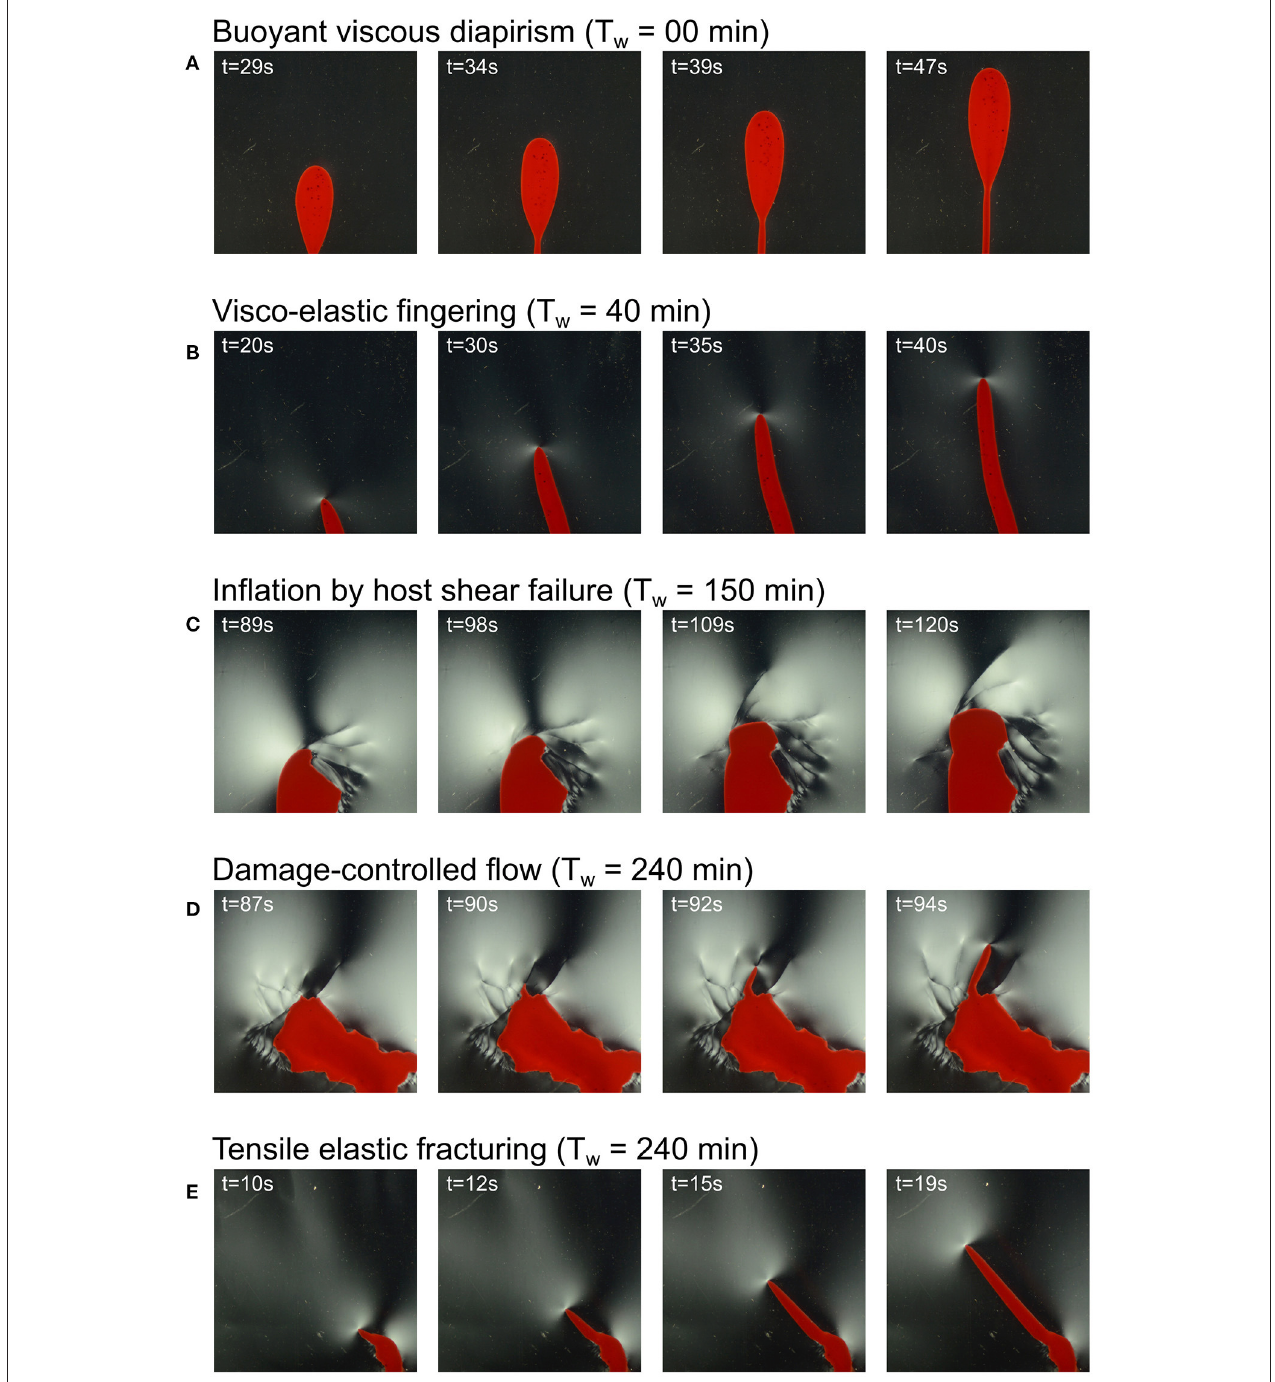
FIGURE 12 | Time series of polarized photographs illustrating characteristic mechanisms of oil emplacement. (A) Viscous diapirism in Experiment E1 ( T w = 0 min). (B) Viscoelastic fingering in Experiment E2 ( T w = 40 min). (C) Intrusion inflation by shear failure of the host in Experiment E6 ( T w = 150 min). (D) Intrusion of sheet intrusion along damage/fault produced during earlier steps of oil intrusions in Experiment E7 ( T w = 240 min). (E) Hydraulic fracturing of sheet intrusion in Experiment E7 ( T w = 240 min). experiment E7, the intrusion during the first stage exhibits a in experiment E2 is accommodated by inelastic flow (see also thin wedge, which thickens while its tip propagates ( Figure 11A , interpretation in section 4.1). Second, the shapes and growth T w = 240 min). Such behavior is in good agreement with the behaviors of the intrusions in both experiments differ. In